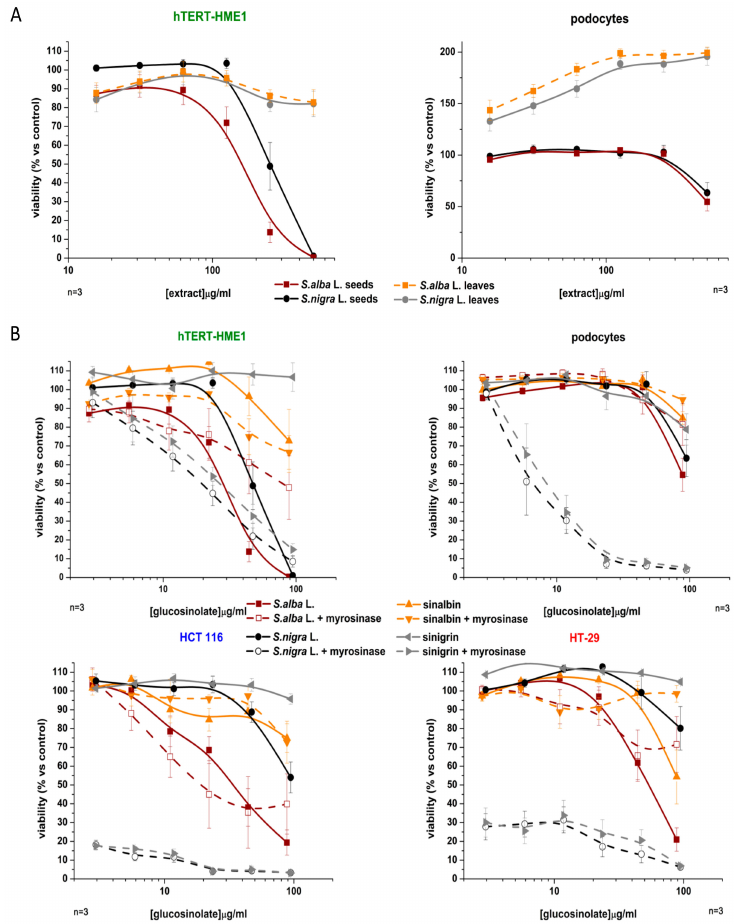
Figure 1. ( A ) Antiproliferative activity of a number of extracts of S. alba and S. nigra in hTERT-HME1 and podocytes. ( B ) Antiproliferative activity of sinalbin (SNB) and sinigrin (SNG), pure and obtained from the EtOH/H 2 O 8:2 seed extract of S. alba and S. nigra , in the presence and absence of